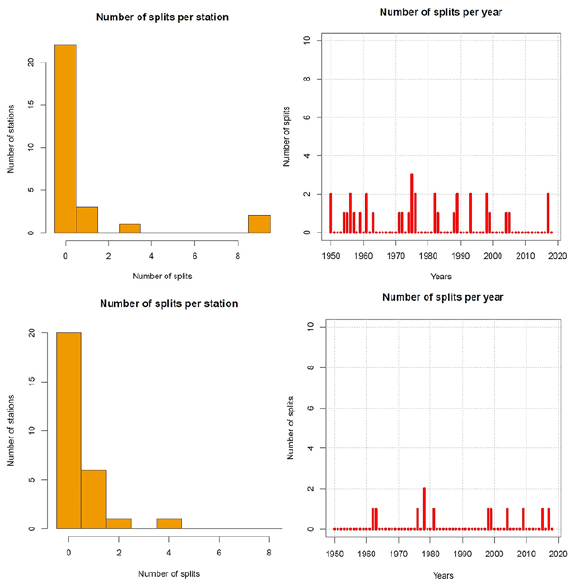
Figure 4. Number of “breaks or splits” or inhomogeneities detected by Climatol in relation to the number of affected stations and the analysis period (1950-2018), concerning